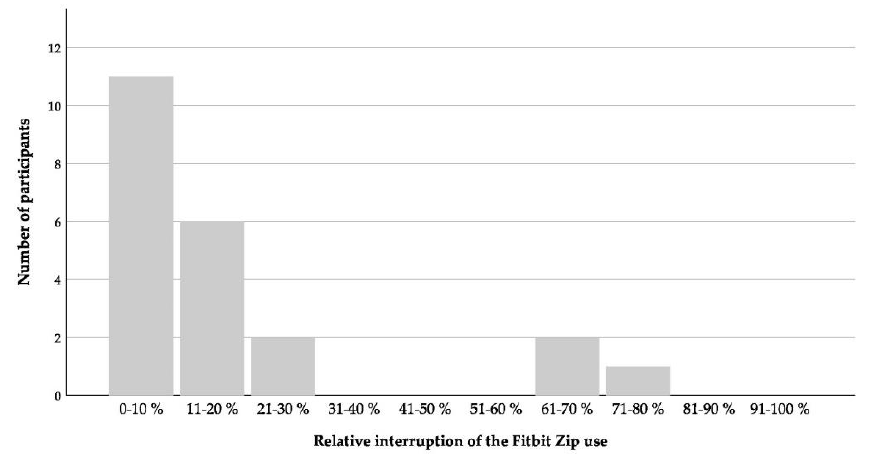
Figure 6. Relative interruption of the Fitbit Zip use during the individual wearing period ( n = 22). Table 5. Reasons for temporarily interruptions of the individual wearing period.